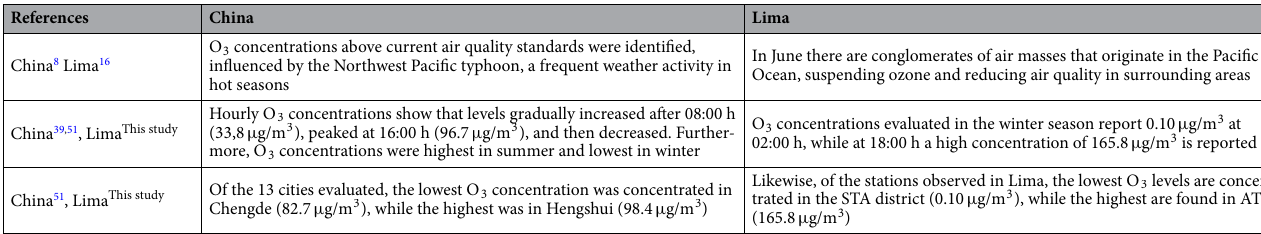
Table 4. Behavior of ozone evaluated both in China and in Peru (Metopolitan